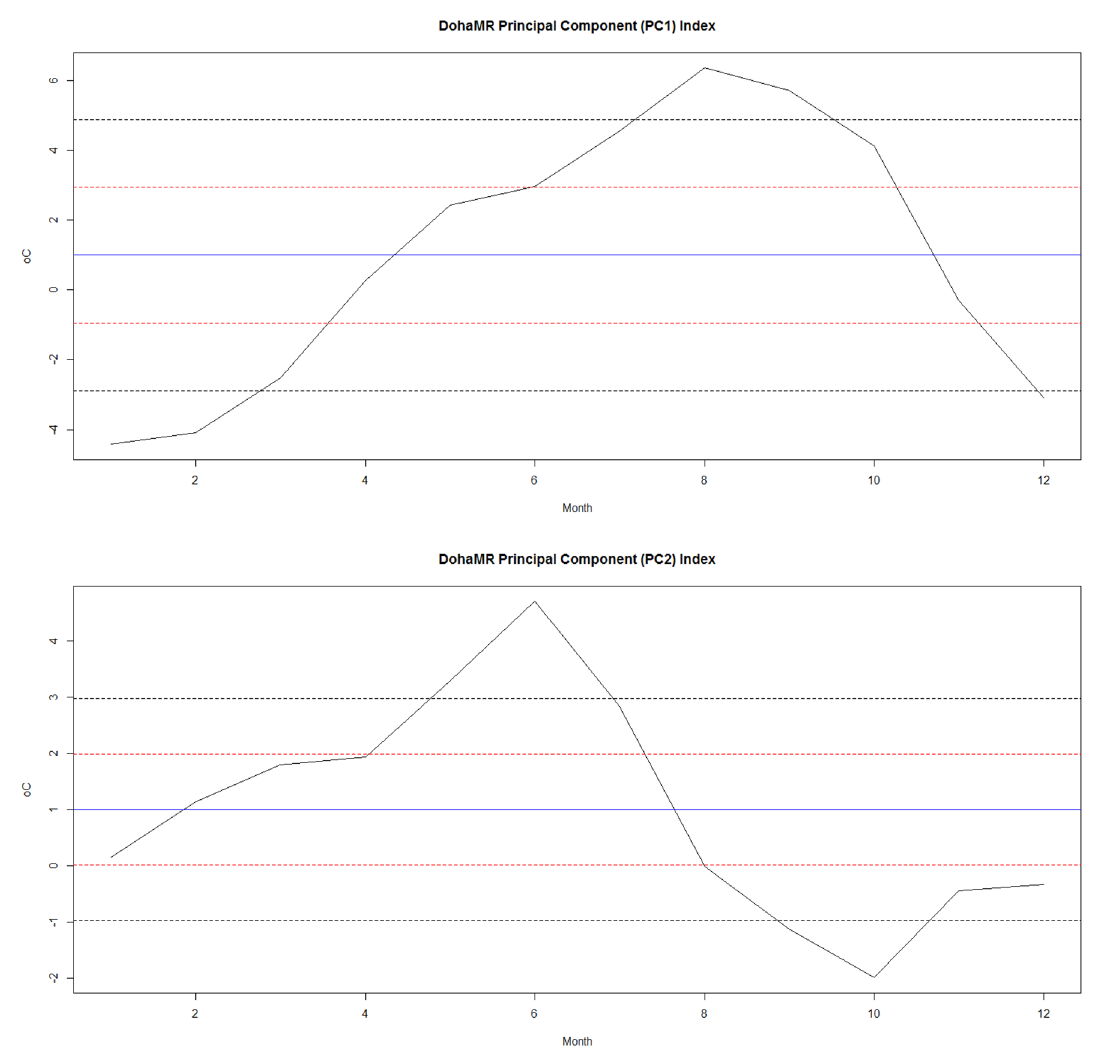
rent climatology, 1991–2020. The blue line is the ensemble average and the red dashed line is the standard deviation-based interval, and the solid lines are the thresholds established in the literature